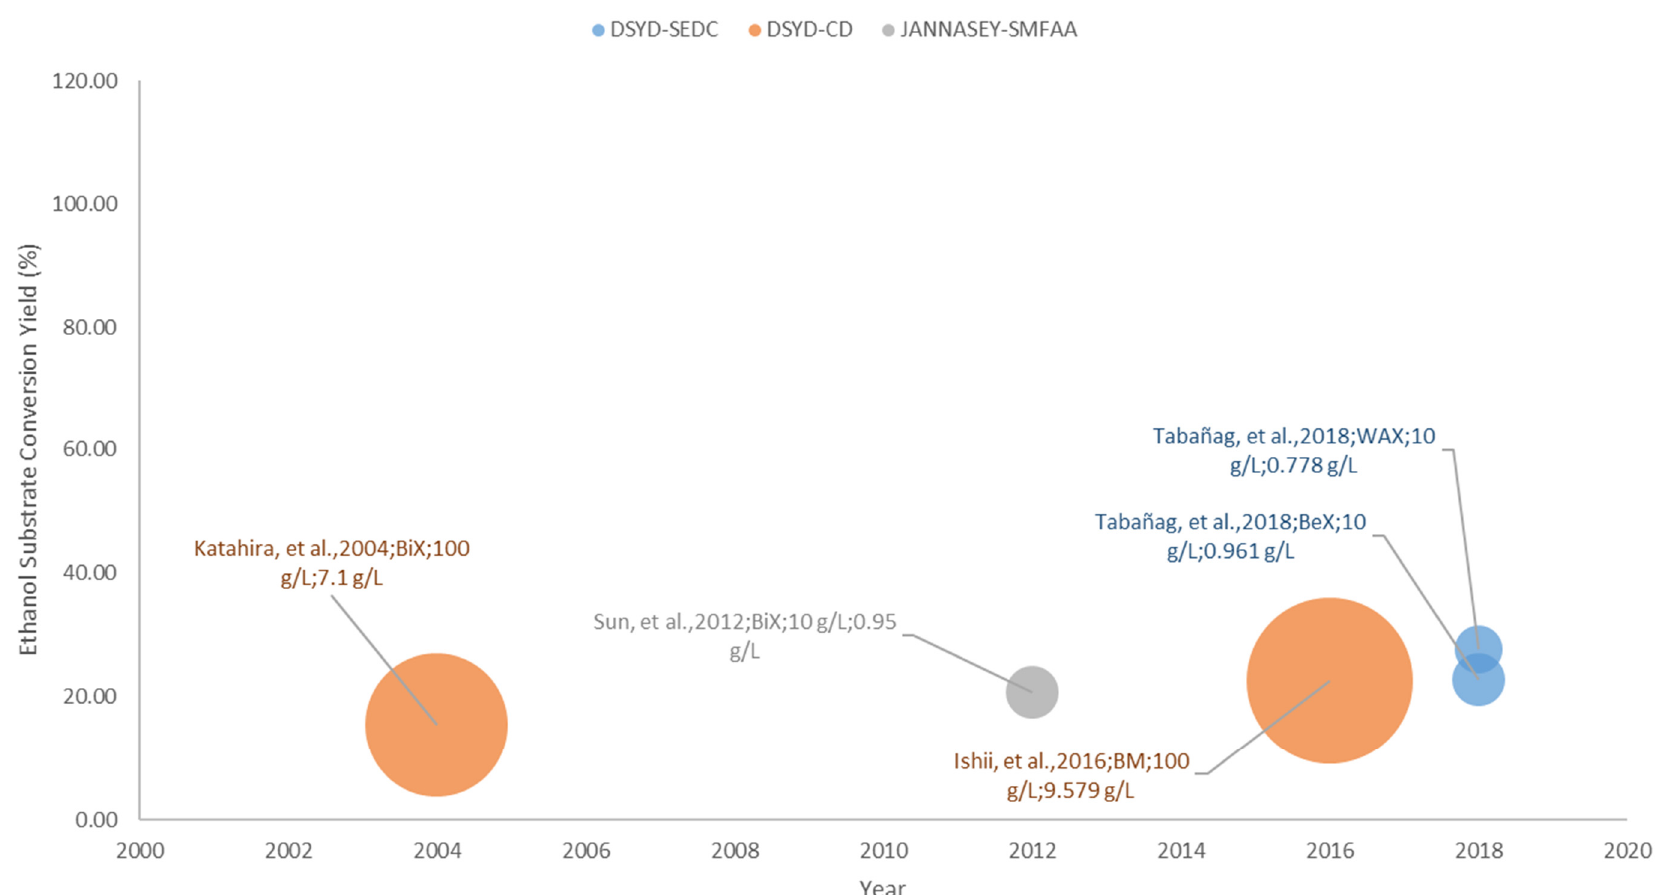
Figure 7. Visualization of the status and development of yeast surface display for Hemicellulosic Bioethanol Production. Bubble sizes represent ethanol titer. Data labels are formatted as follows: (Reference (author-date); Substrate; Substrate Concentration; Ethanol Titer).